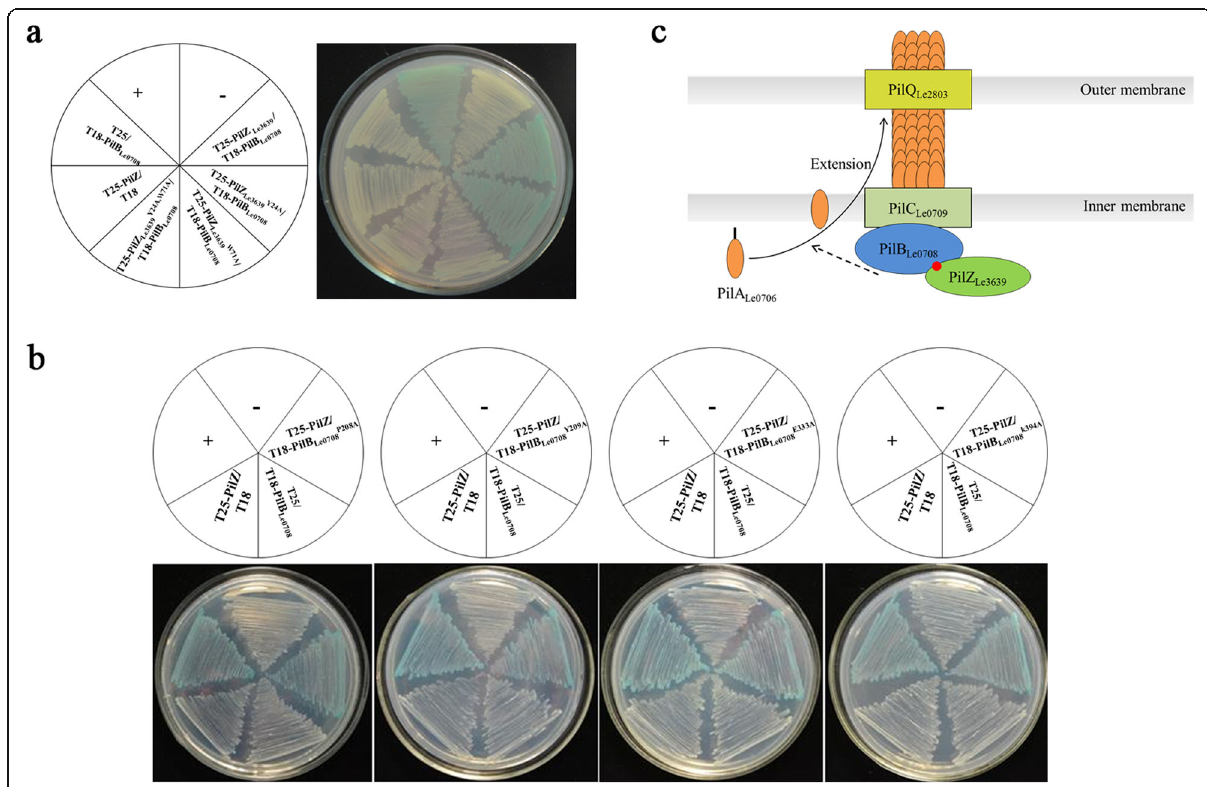
Fig. 5 Identification of key amino residues of PilZ Le3639 or PilB Le0708 that required for their binding determined by the BACTH system. a The W71, but not the Y24 residue of PilZ Le3639 was essential for its binding with PilB Le0708. The Y24 and W71 residues were site-mutated respectively, and cloned into pKT25 vector. The coding region of PilB Le0708 was cloned into pUT18c. b All the test residues of PilB Le0708, including P208, Y209A, K333, E397 were not involved in the binding PilB Le0708 with PilZ Le3639. “ + ” , a positive control (pUT18c-Zip &pKT25-Zip), “ - ” , a negative control (pUT18c &pKT25). c A schematic model for the PilZ Le3639 -PilB Le0708 complex regulating T4P-dependent twitching motility in Lysobacter enzymogenes OH11.